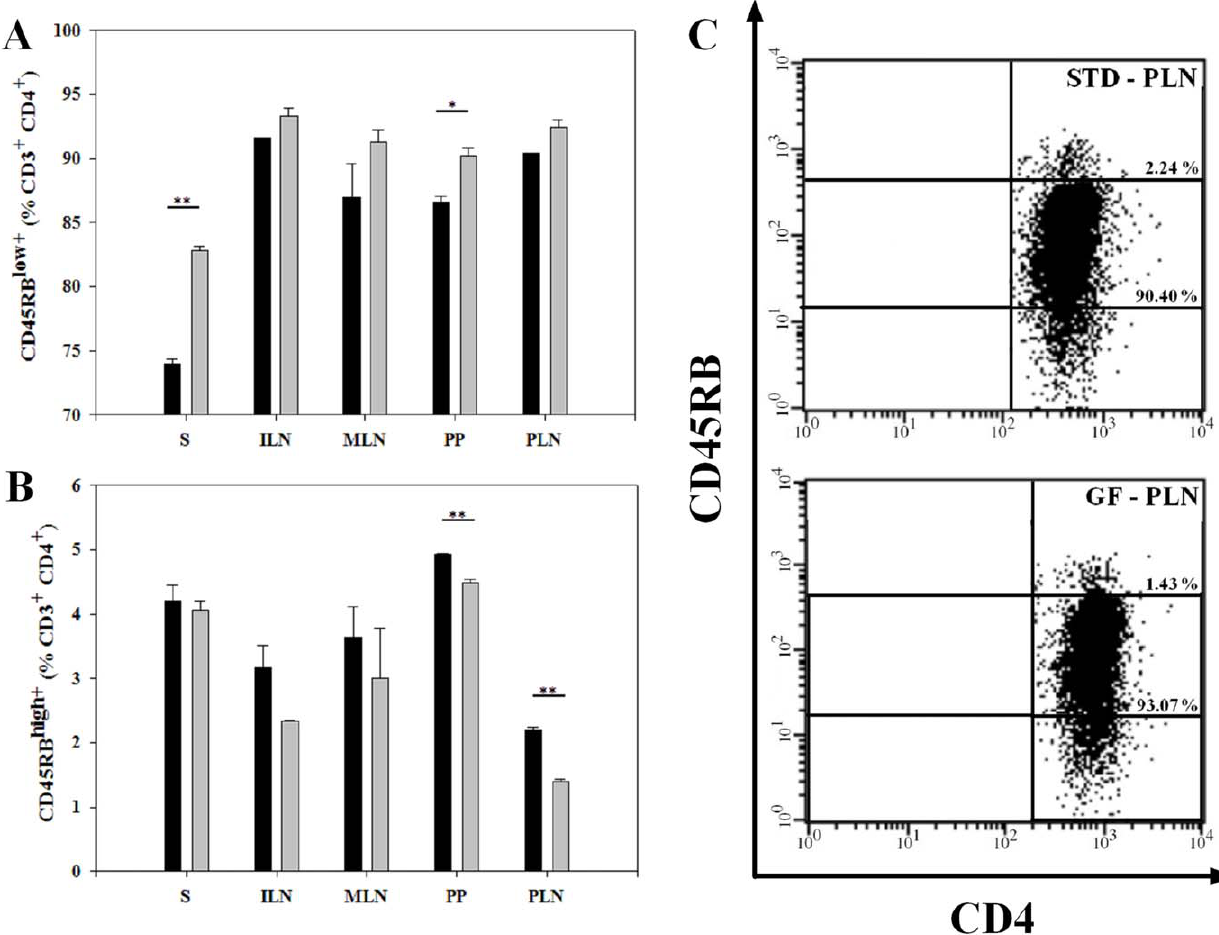
Figure 4. The proportion of CD4 + T cells expressing CD45RB high and CD45RB low was influenced by the diet. ( A ) Bars represent percentages of CD45RB low expressing cells gated on 100% CD3 + CD4 + cells. There was a decreased proportion of CD4 + CD45RB low T cells in S and PP of BALB/c mice receiving the STD diet compared to the GF diet. ( B ) Percentages of cells expressing CD45RB high gated on 100% CD3 + CD4 + cells. There was an increased proportion of CD4 + CD45RB high T cells in PP and PLN in mice receiving the STD diet. Data are presented as mean values 6 SEM of two independent experiments with 6 mice in each group. ( C ) Representative dot plot of cells isolated from PLN showing the proportion of CD45RB low and CD45RB high CD4 + T cells from STD mice vs. GF mice. Spleen (S); inguinal lymph nodes (ILN); mesenteric lymph nodes (MLN); Peyer’s patches (PP) and pancreatic lymph nodes (PLN). Black bars: STD diet. Grey bars: GF diet. * P , 0.05. ** P , 0.01.